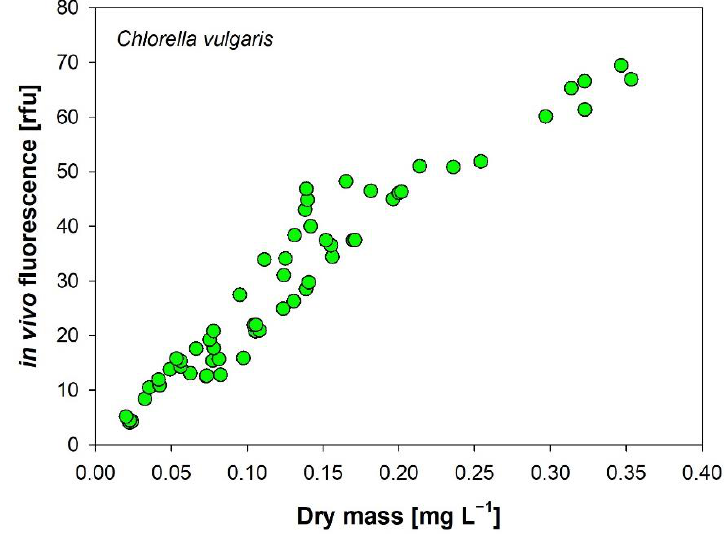
Figure 8. Growth of Chlorella vulgaris monitored by DM and in vivo chlorophyll autofluorescence (instrument SHIMADZU RF-5301PC). Samples with DM > 0.25 g L −1 (corresponds to OD ~ 0.5) were diluted with medium before measurements and the values multiplied by the dilution factor.